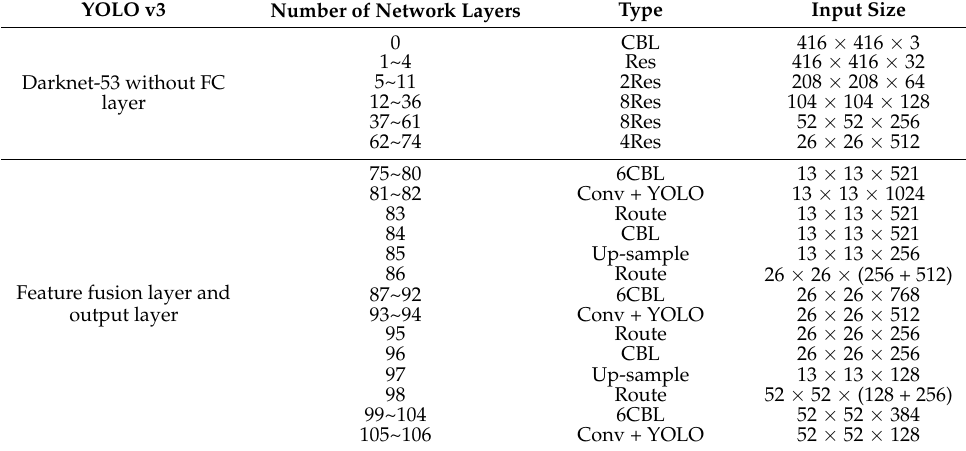
Table 1. Network Structure of ginger recognition. YOLO